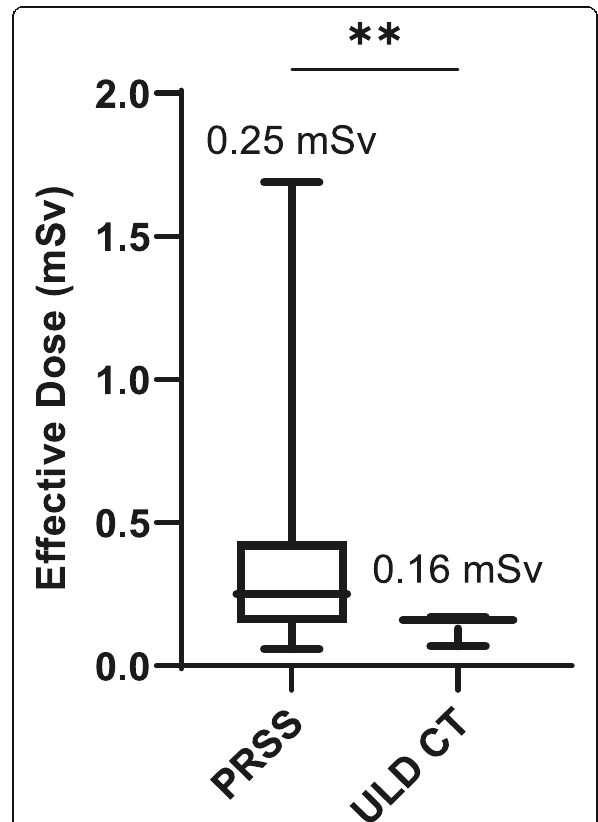
Fig. 3 Radiation dose reduction with ultralow-dose computed tomography (ULD CT) using pure iterative reconstruction. Comparison of the effective dose (mSv) between plain radiographic shunt series (PRSS) and ULD CT using a Wilcoxon matched-pairs signed rank test (** p = 0.002). Data represent the median,